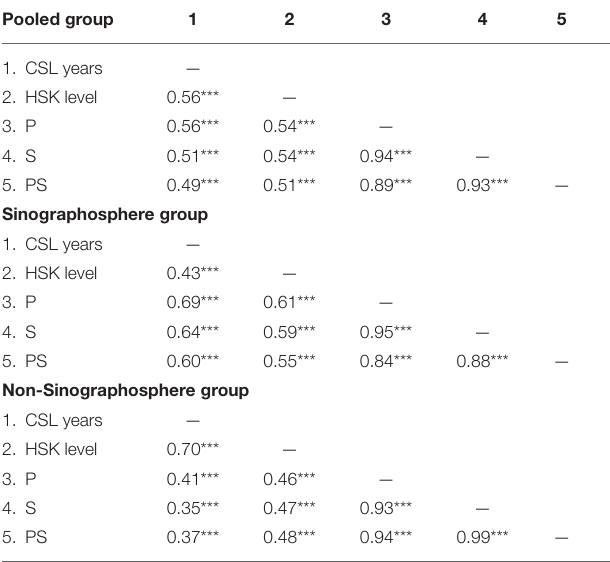
TABLE 8 | Correlation matrix between measured variables. Pooled